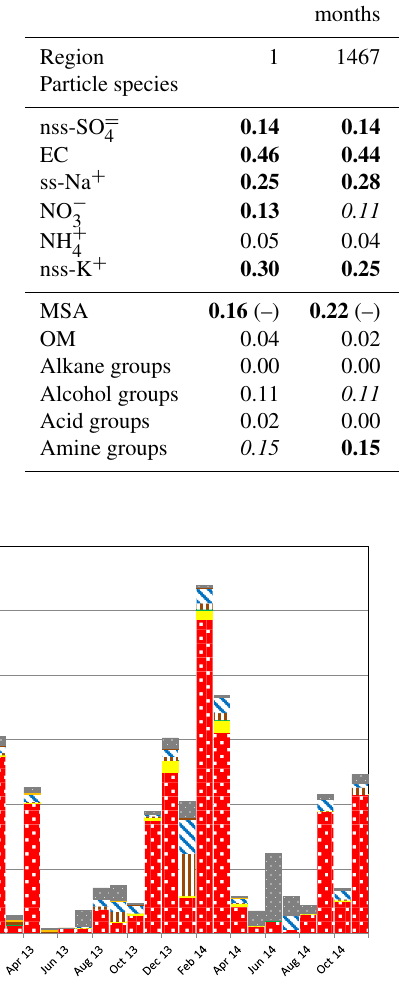
Figure 6. Monthly-averaged percentage of previous 10 days spent below 100m over Regions 1–10 identified in Fig. 1. Results are from the FLEXPART trajectory analyses for daily air parcels arriv- ing at